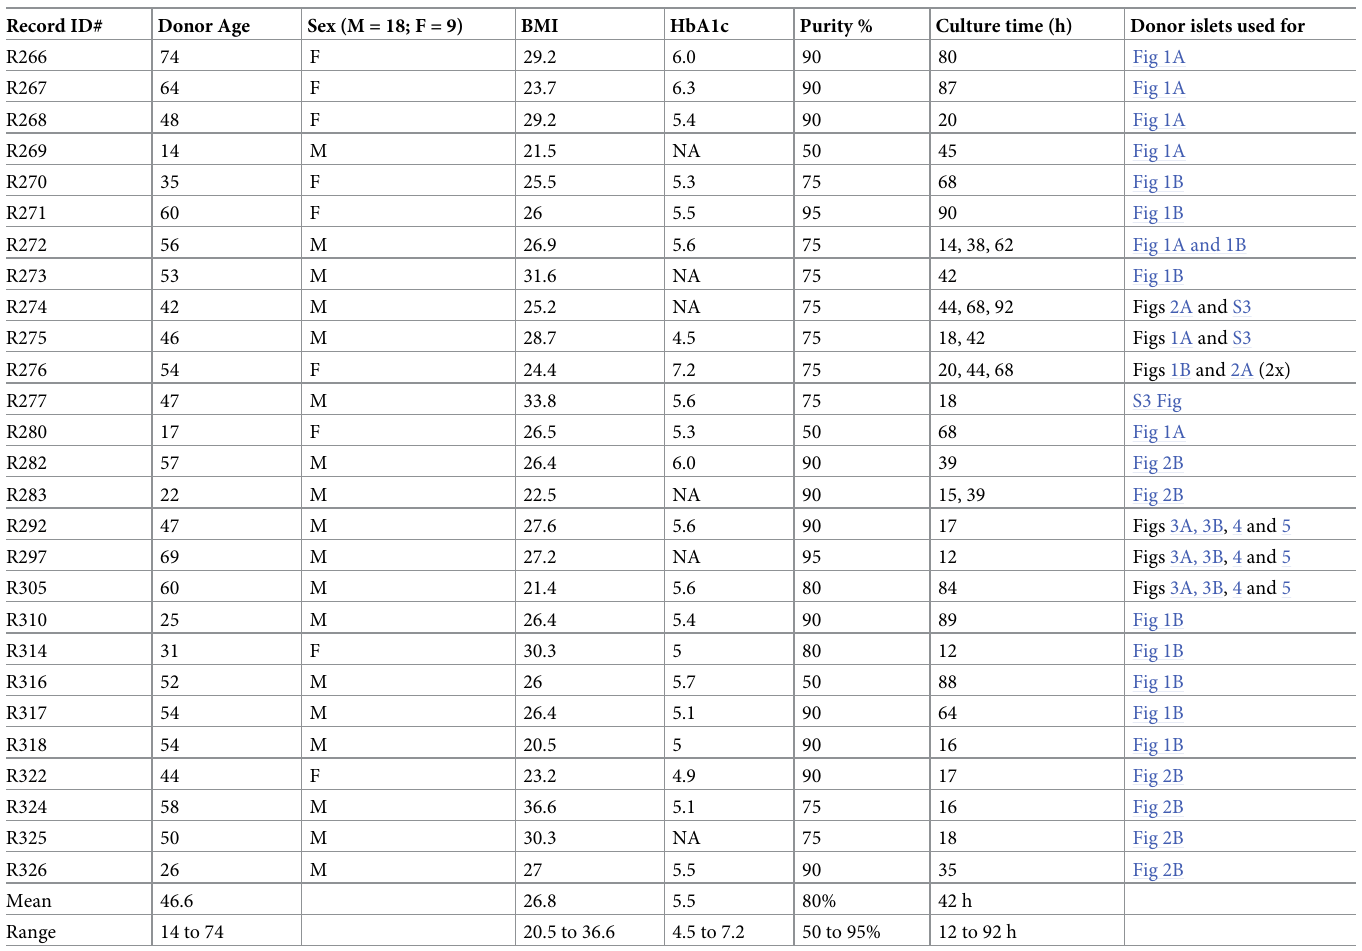
Table 1. Characteristics of pancreatic islet